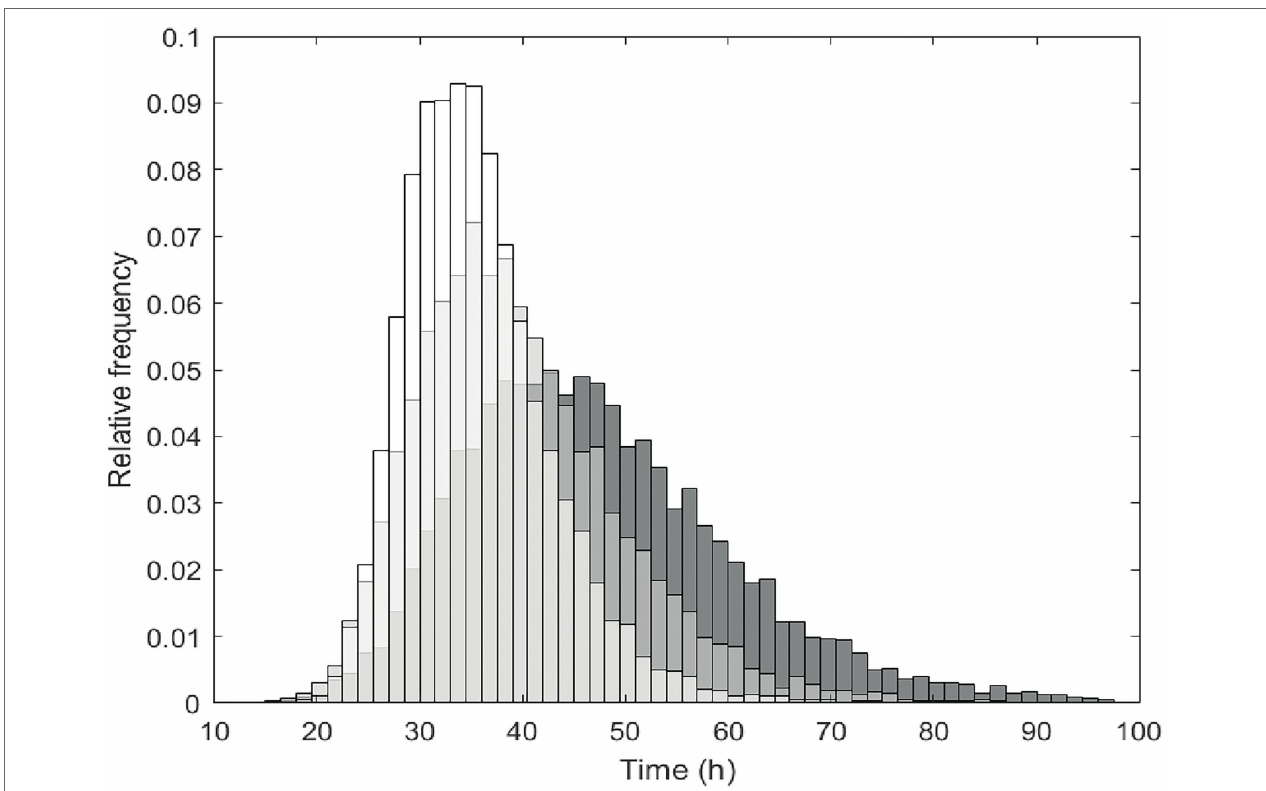
FIGURE 3 | The simulated distributions of Lacticaseibacillus paracasei population randomly generated that reached the targeted probiotic level fixed at 7 log 10 CFU/g during fermentation time at 20 ° C (grey), 25 ° C (light grey) and 35 ° C (white). Simulations were obtained in cabbage considering a virtual initial probiotic inoculum of 4 log 10 CFU/g ± 0.5 at pH 6.0 ± 0.2 during 4